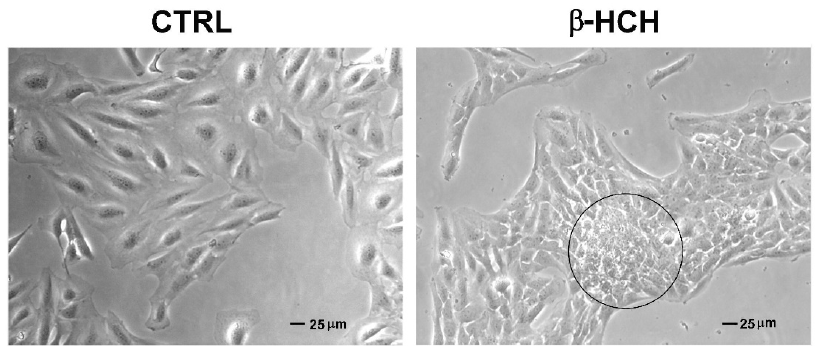
Figure 9. β -HCH-induced morphological changes in BEAS-2B cells. Cells were seeded at 3 × 10 5 cells/well and, after 24 h, were exposed to 10 µ M β -HCH for 48 h. The different cell arrangement induced by β -HCH is evidenced in the black circle. The selected images are representative of three independent experiments.